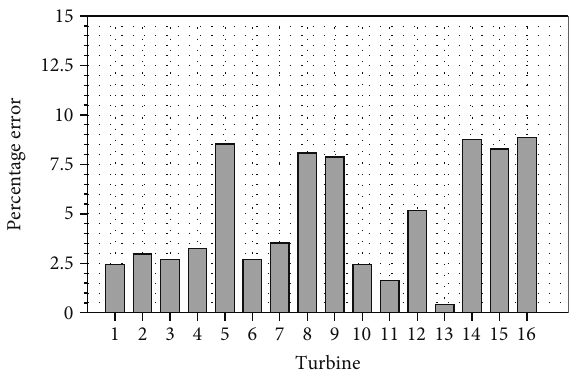
Figure 5: Smallest coarse mesh versus largest fi ne mesh power coe ffi cient